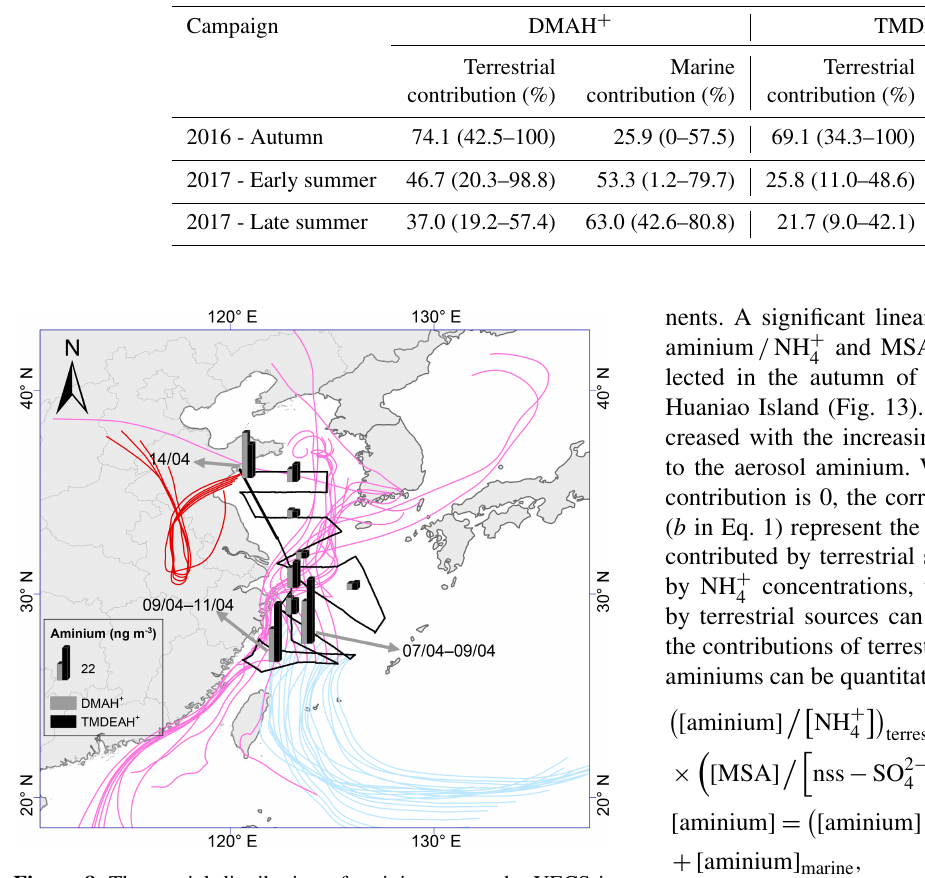
Figure 8. The spatial distribution of aminiums over the YECS in the spring of 2017.The light blue, pink and red lines represent 72h backward trajectories corresponding to sample sets collected on 7– 9, 9–11 and 14 April,